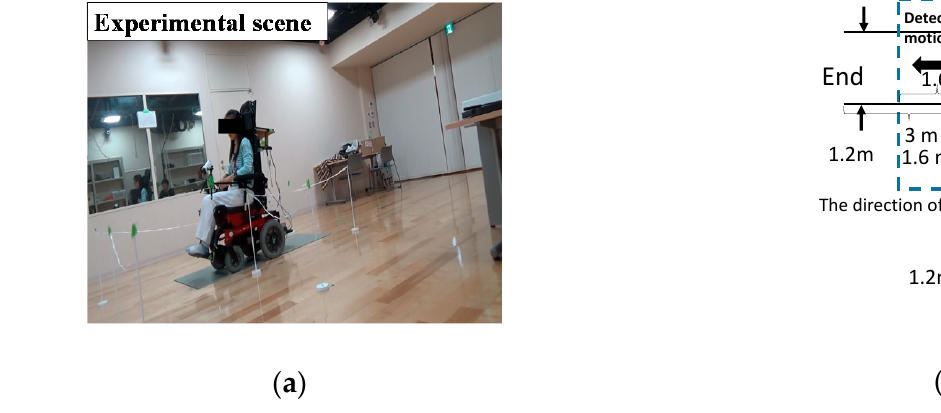
Figure 8. Experimental setup: ( a ) experimental scene and ( b ) course setting.